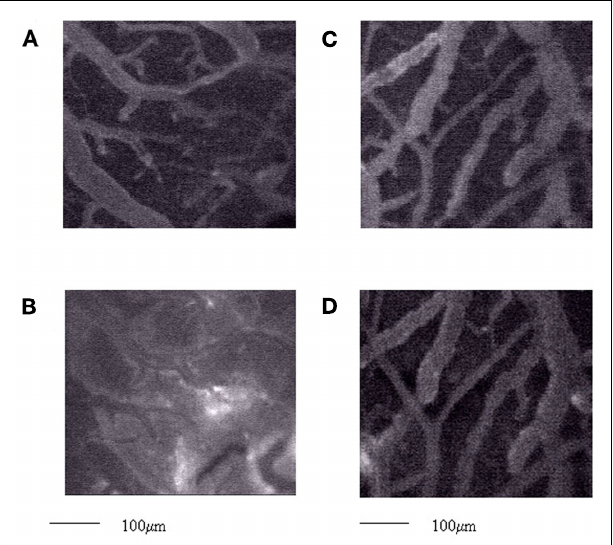
FIGURE 3 | Computer-assisted image of a pial microvascular network under baseline conditions (A) and at the end of reperfusion (B) in an ischemic rat. The increase in permeability is outlined by the marked change in the color of interstitium (from black to white). Computer-assisted image of a pial microvascular network under baseline conditions (C) and at the end of reperfusion (D) in a quercetin-treated rat (5.0mg/kg b.w.), where there was no leakage of fluorescent-dextran. Scale bar = 100 μ